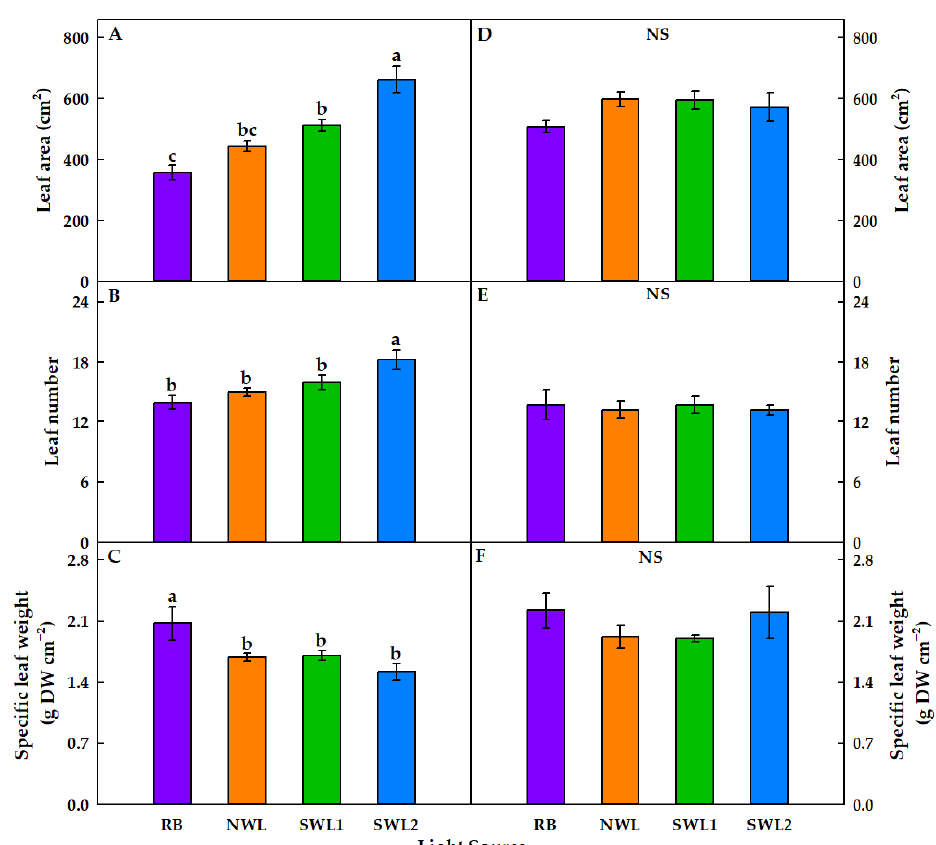
Figure 4. Leaf area, leaf number, and specific leaf weight of butterhead lettuce ( A – C ) and romaine lettuce ( D – F ) plants grown under various light sources with the same electrical power after 4 weeks of transplanting. Different letters indicate Scheme 0. ( n = 4).